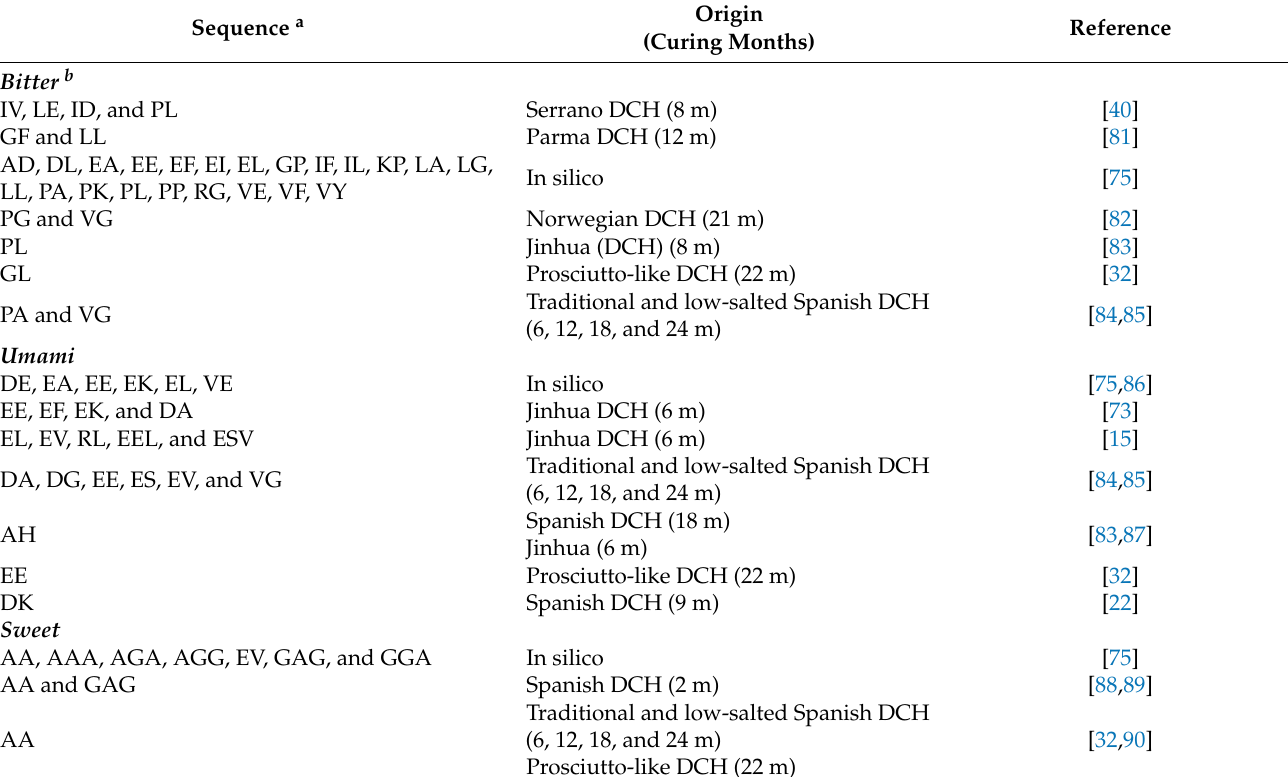
Table 2. Taste characteristics of dry-cured ham (DCH)-derived di- and